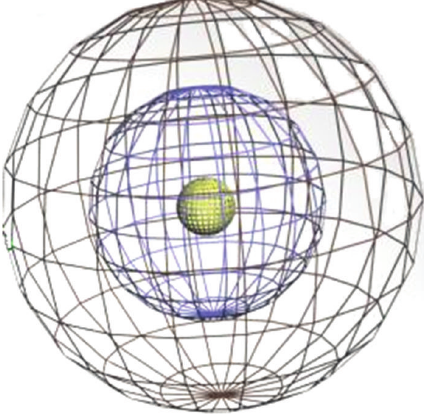
Figure 4: The schematic view (3D) of the related